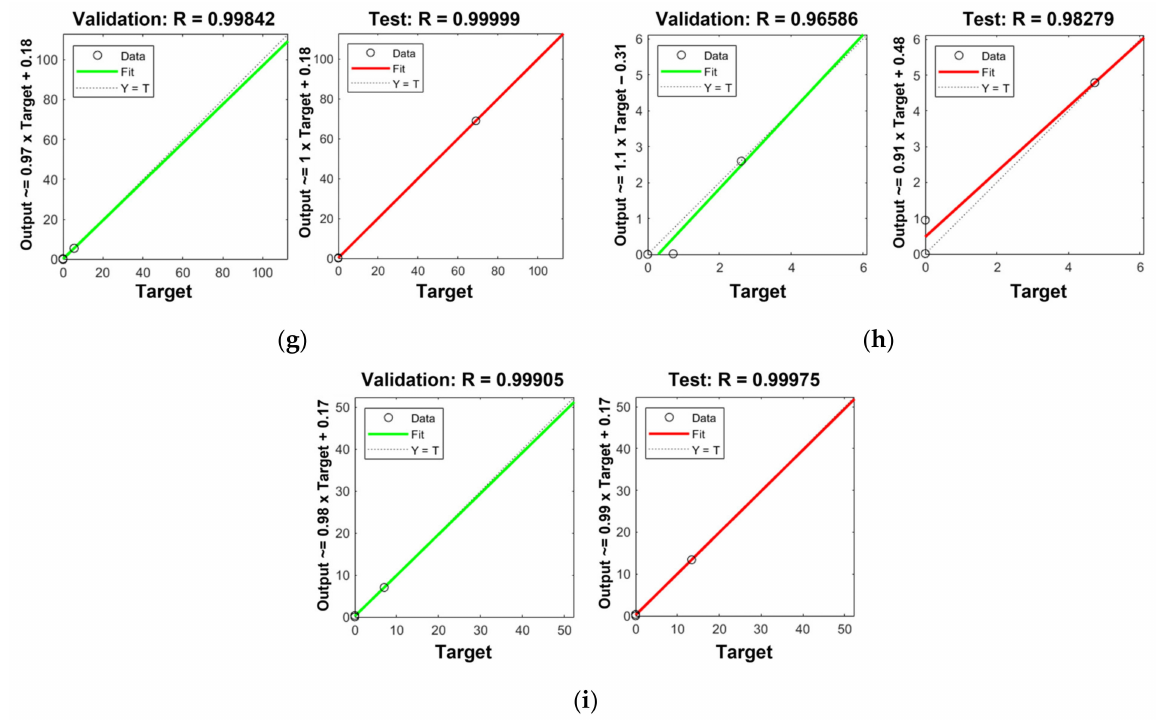
Figure A3. Regression plots for sediments: ( a ) Arsenic, ( b ) Barium, ( c ) Chromium, ( d ) Copper,